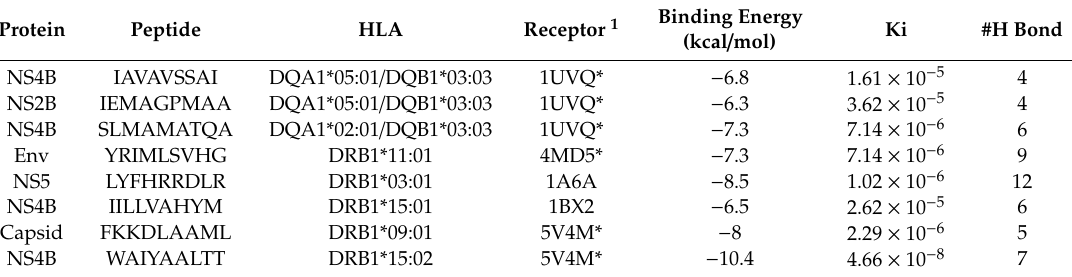
Table 5. Summary of docking results of epitope with